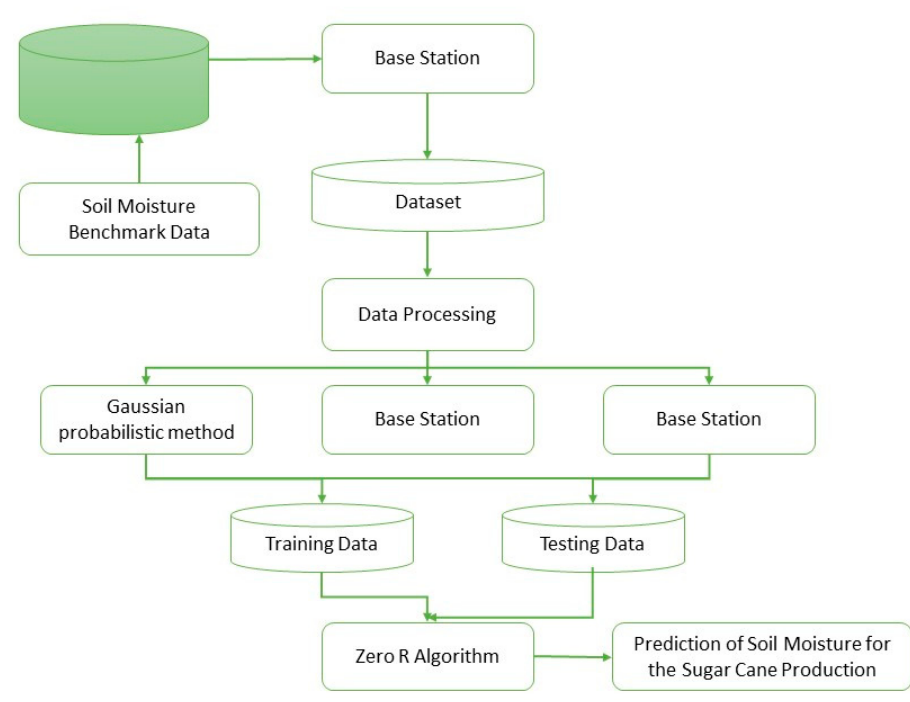
Figure 4. The proposed model for soil precision in agriculture using Hybrid Algorithm. The algorithm of the proposed approach is given below.